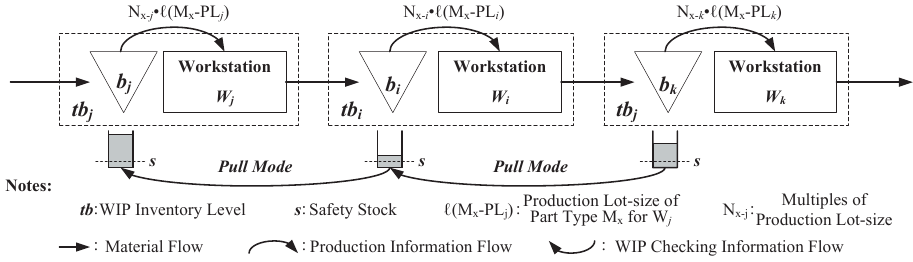
Fig. 5. The logic of the Pull production mode based on an inventory level